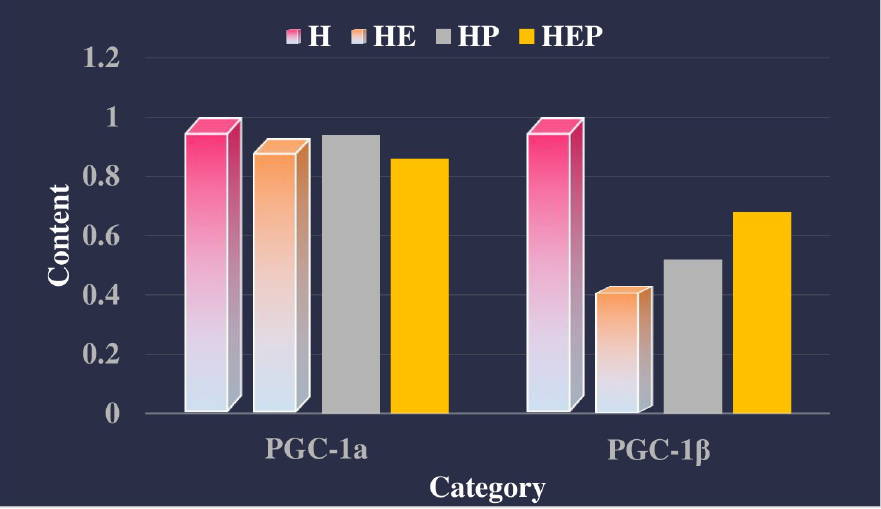
Fig 1. Effect of PDTC on relative gene content of rats in extensor digitorum longus muscle of rats.